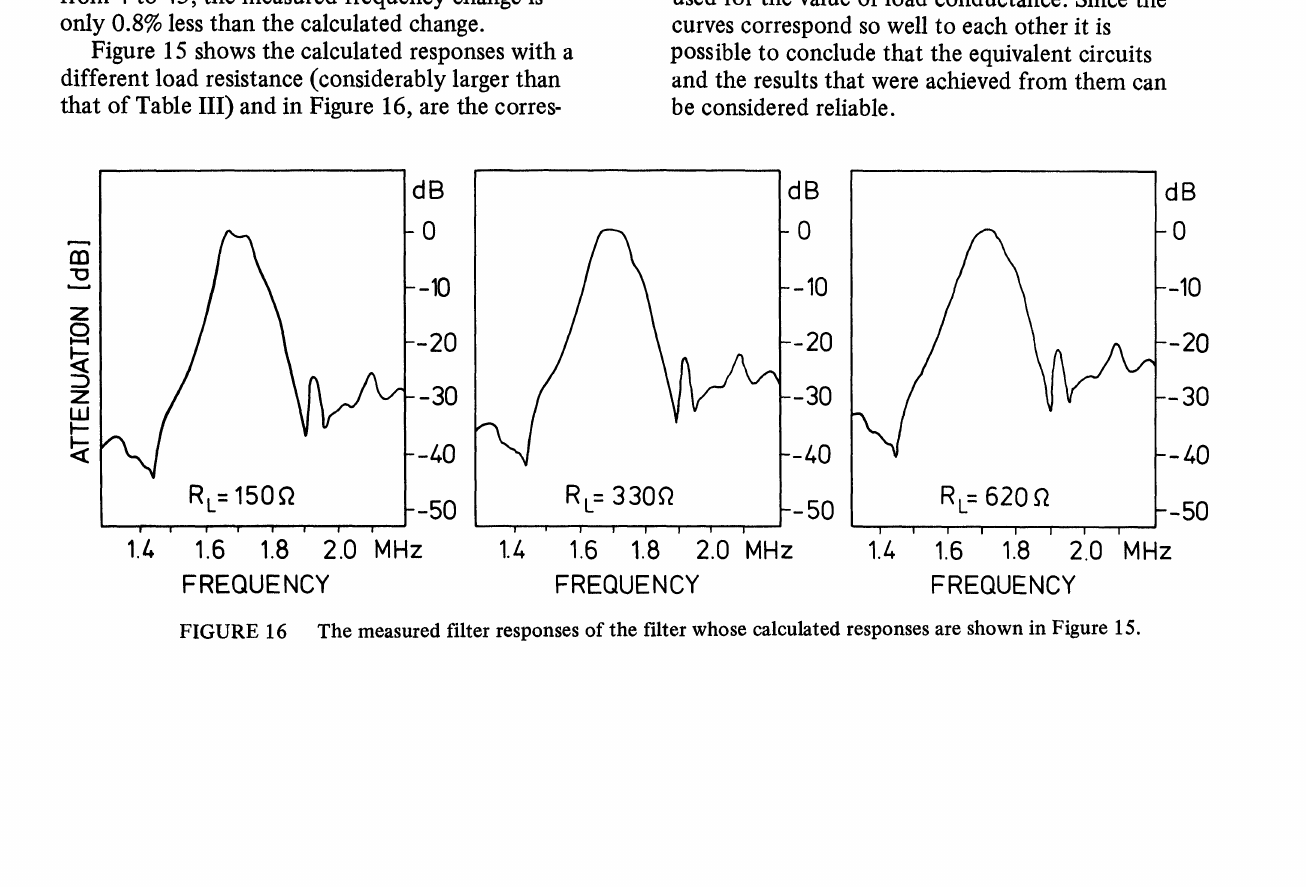
curves correspond so well to each other it is